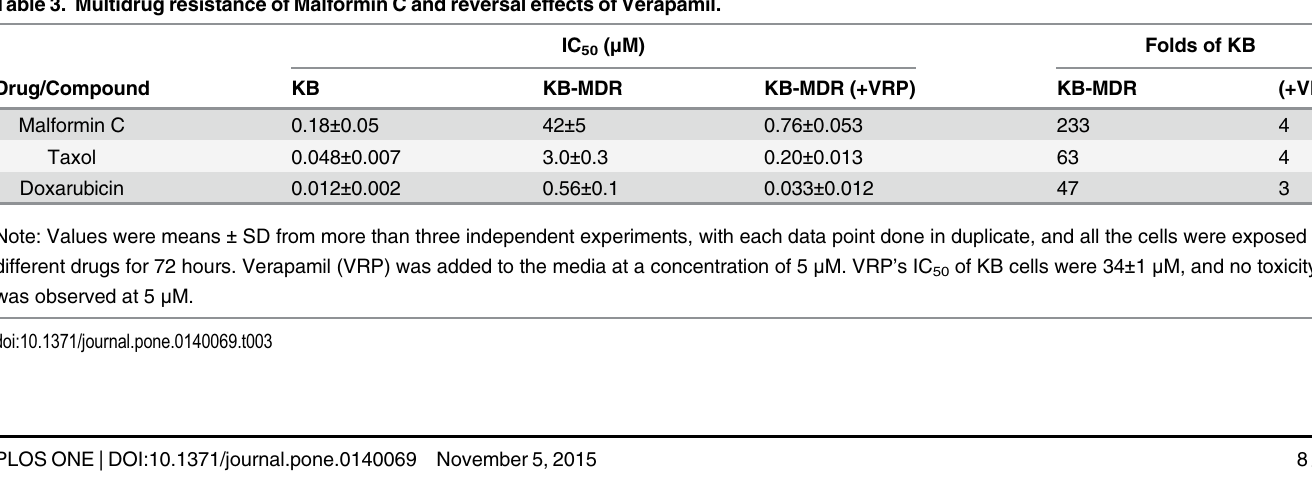
Table 3. Multidrug resistance of Malformin C and reversal effects of Verapamil.